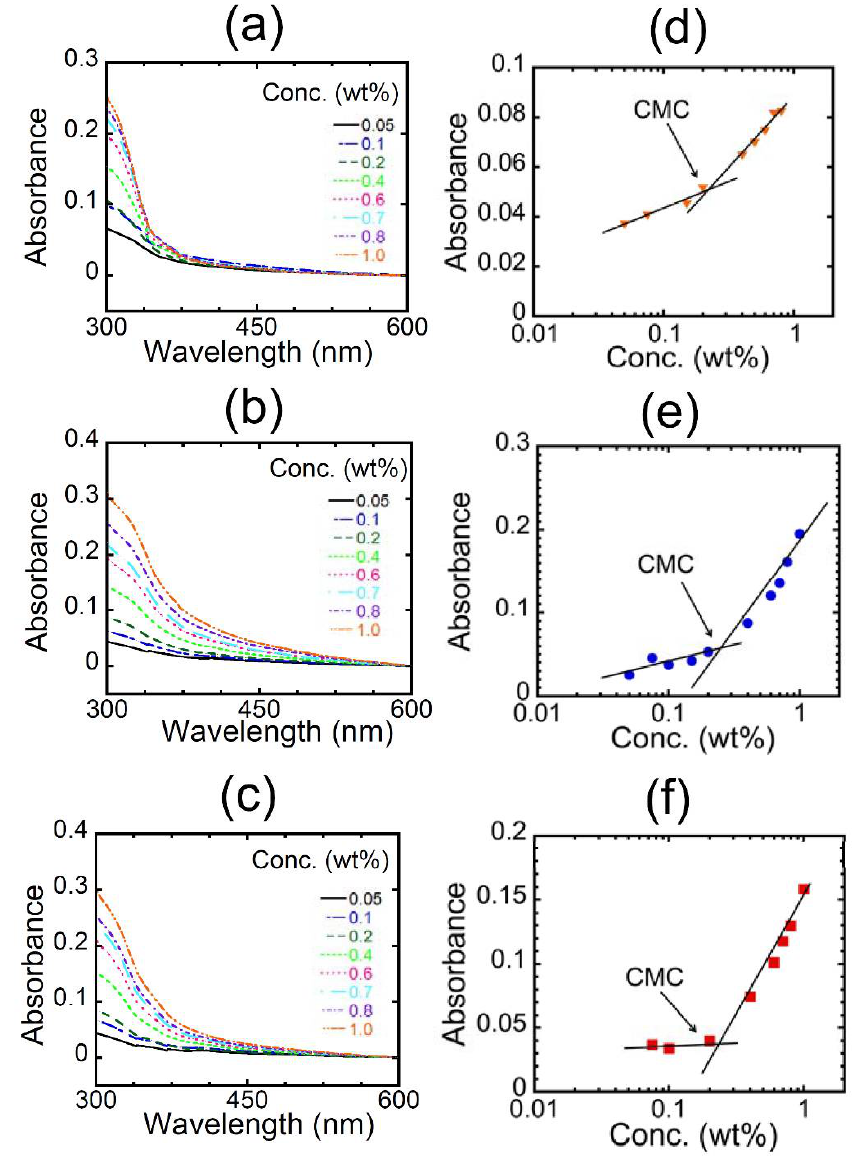
Figure 4. UV-vis spectra of ( a ) HE-Pep, ( b ) Pr-Pep, and ( c ) Me-Pep at various concentrations and the absorbance of ( d ) HE-Pep (orange triangle), ( e ) Pr-Pep (blue circle), and ( f ) Me-Pep (red square) at 340 nm as a function of concentration (wt%) at 25 °C.